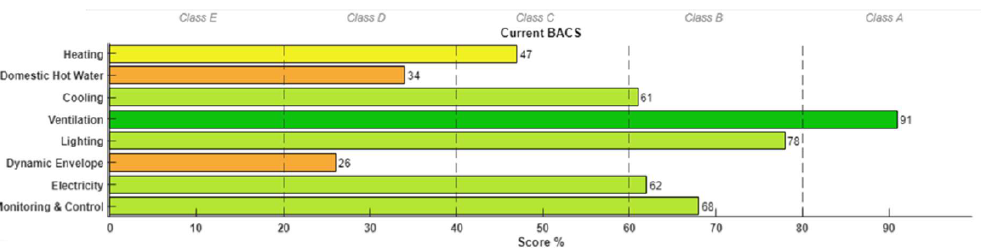
Figure 9. BACS auditing results for case study C along with domains assessment classes, the greener the bar color the higher the rating.